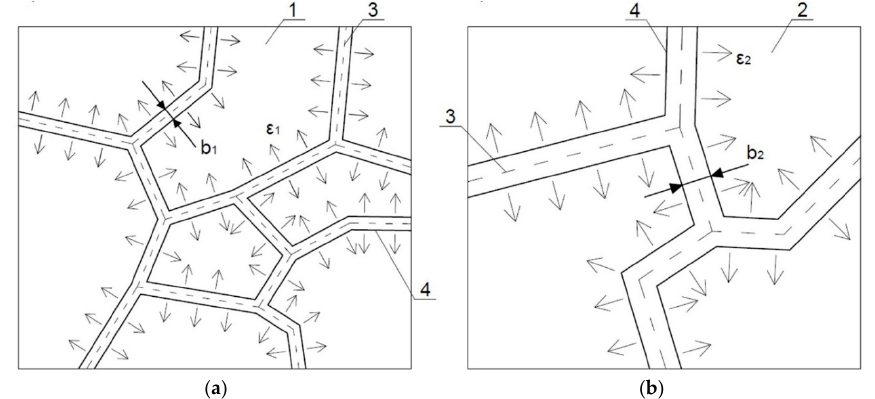
Figure 6. Crack width after the thermal load for clusters of: ( a ) small sizes; ( b ) large sizes; 1, 2—clusters with A 1 and A 2 areas, where A 1 < A 2 ; 3—separation surface between clusters; 4—edges of a crack after deformation of clusters; b 1 , b 2 —crack width, where b 1 < b 2 ; ε 1 , ε 2 —direction and size of clusters deformations, where ε 1 < ε 2 .